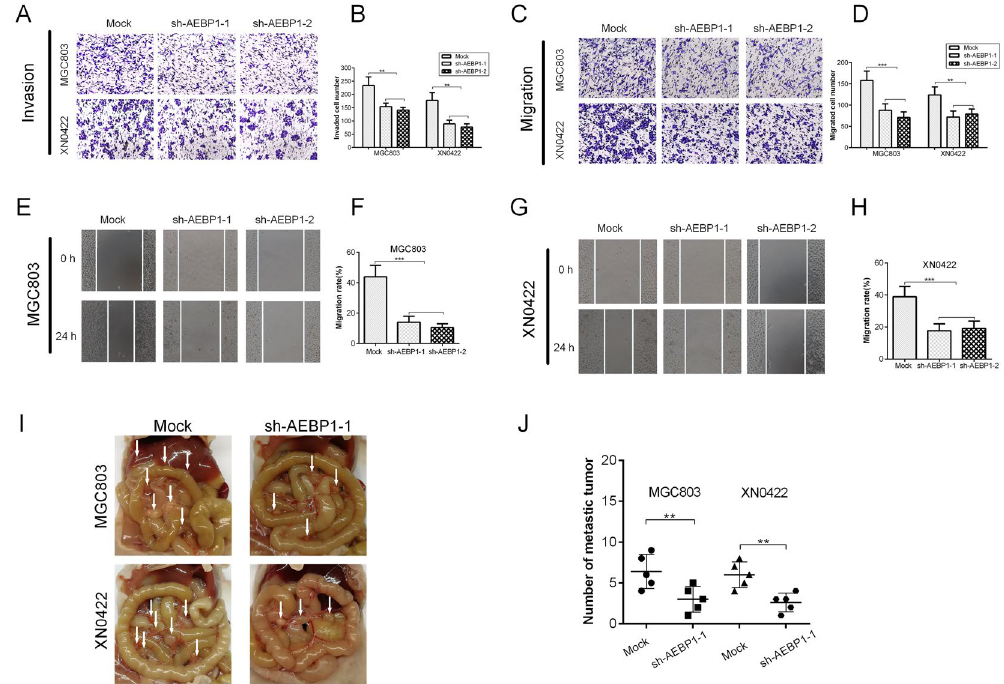
Figure 5. Silencing AEBP1 impairs the migratory, invasive and metastatic capabilities of gastric cancer cells. ( A ) Representative images of transwell invasion assays showing decreased invasive capabilities of GC cells with knockdown of AEBP1; magnification: 200 × . ( B ) Quantification of the transwell invasion assay results; ** P < 0.01. ( C ) Representative images of transwell migration assays showing decreased migratory capabilities of GC cells with knockdown of AEBP1; magnification: 200 × . ( D ) Quantification of the transwell